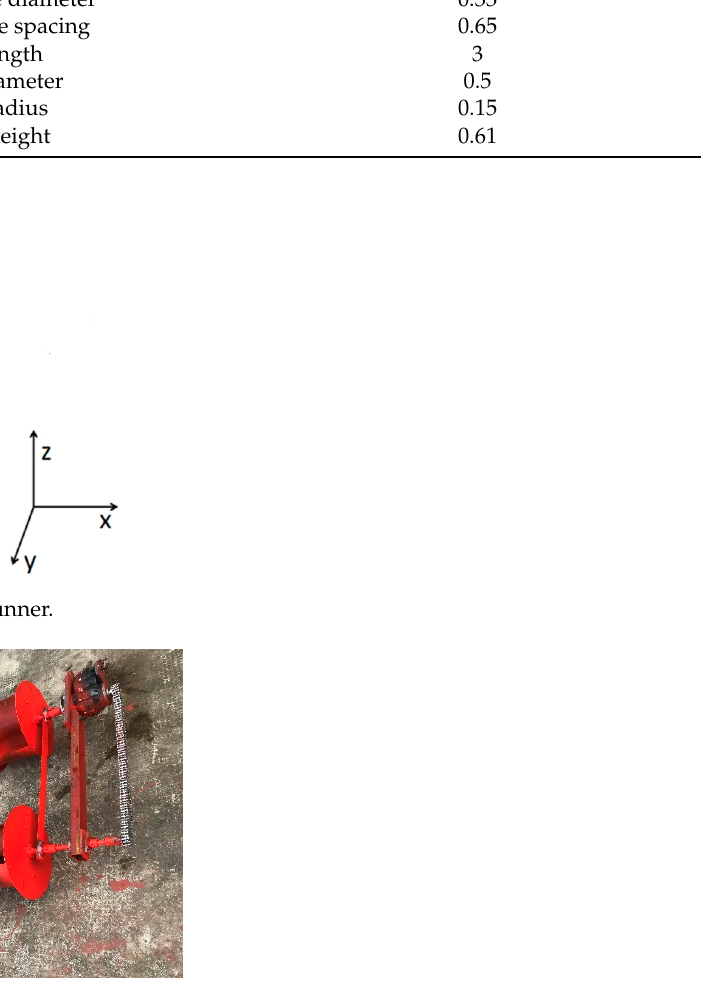
Figure 2. Physical model of s-type runner.